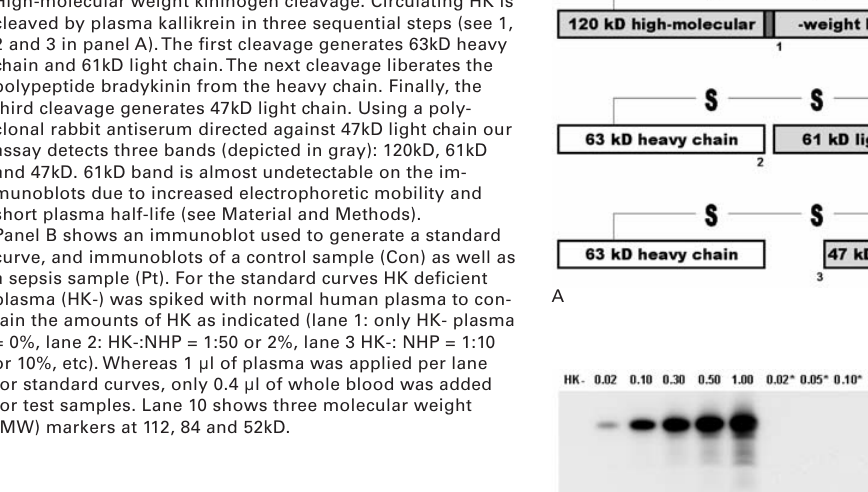
High-molecular weight kininogen cleavage. Circulating Hk is cleaved by plasma kallikrein in three sequential steps (see 1, 2 and 3 in panel A).The first cleavage generates 63kd heavy chain and 61kd light chain.The next cleavage liberates the polypeptide bradykinin from the heavy chain. Finally, the third cleavage generates 47kd light chain. Using a poly- clonal rabbit antiserum directed against 47kd light chain our assay detects three bands (depicted in gray): 120kd, 61kd and 47kd. 61kd band is almost undetectable on the im- munoblots due to increased electrophoretic mobility and short plasma half-life (see Material and Methods). Panel B shows an immunoblot used to generate a standard curve, and immunoblots of a control sample (Con) as well as a sepsis sample (Pt). For the standard curves Hk deficient plasma (Hk-) was spiked with normal human plasma to con- tain the amounts of Hk as indicated (lane 1: only Hk- plasma = 0%, lane 2: Hk-:NHP = 1:50 or 2%, lane 3 Hk-: NHP = 1:10 or 10%, etc). Whereas 1 μl of plasma was applied per lane for standard curves, only 0.4 μl of whole blood was added for test samples. lane 10 shows three molecular weight (MW) markers at 112, 84 and